Question: What caption would you write for this figure?
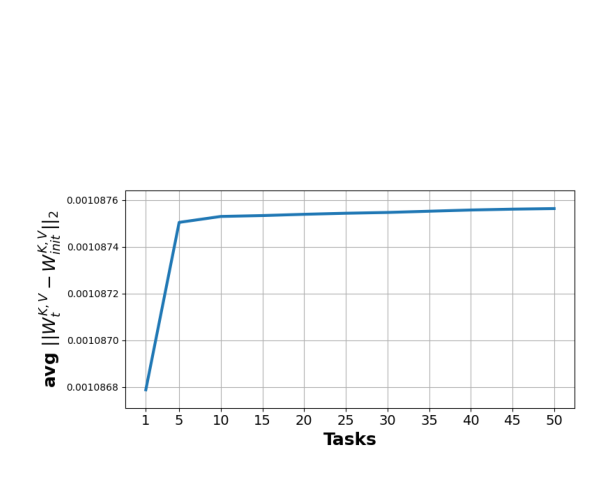
Answer: Average distance from pre-trained weights, given as ||W K,V t −W K,V init ||2, vs task for C-LoRA [1].